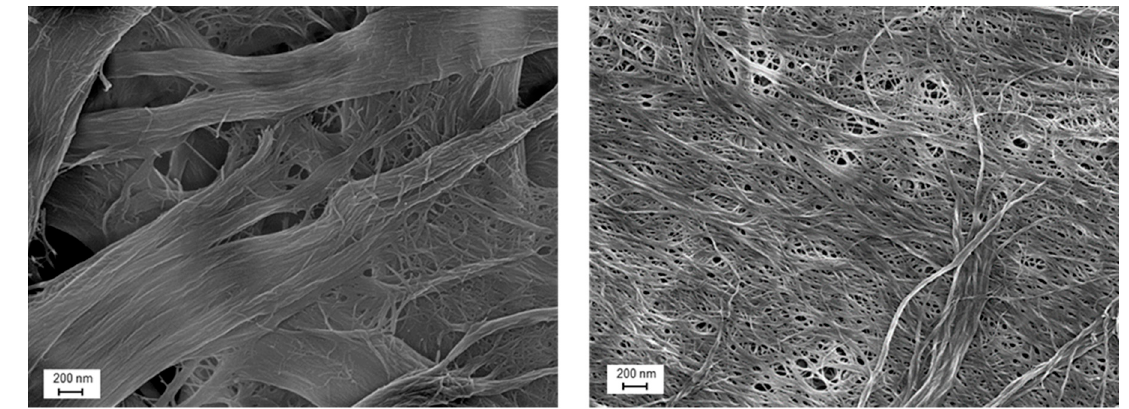
Figure 2. SEM images of fibrillated samples. HefCel CMF (left) and CNF kraft pulp (right).